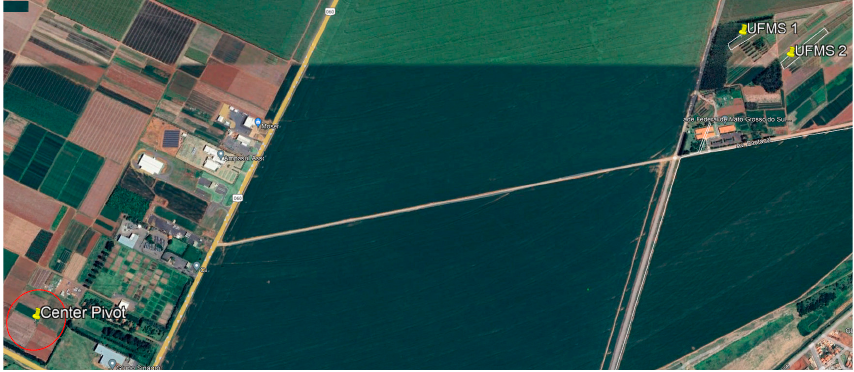
Figure 1. The location of the center pivot agricultural area was used to investigate irrigation manage- ment for soybean cultivation (Experiment 1), while the agricultural areas were named UFMS 1 and UFMS 2 (Experiment